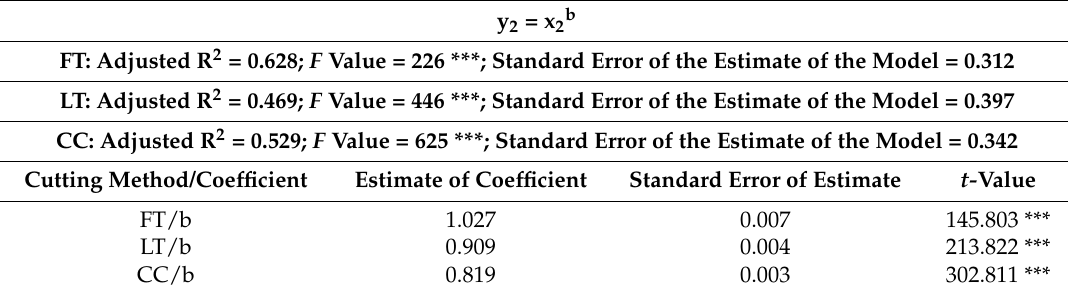
Table 4. Regression models for the hectare-based consumption of stump treatment material.